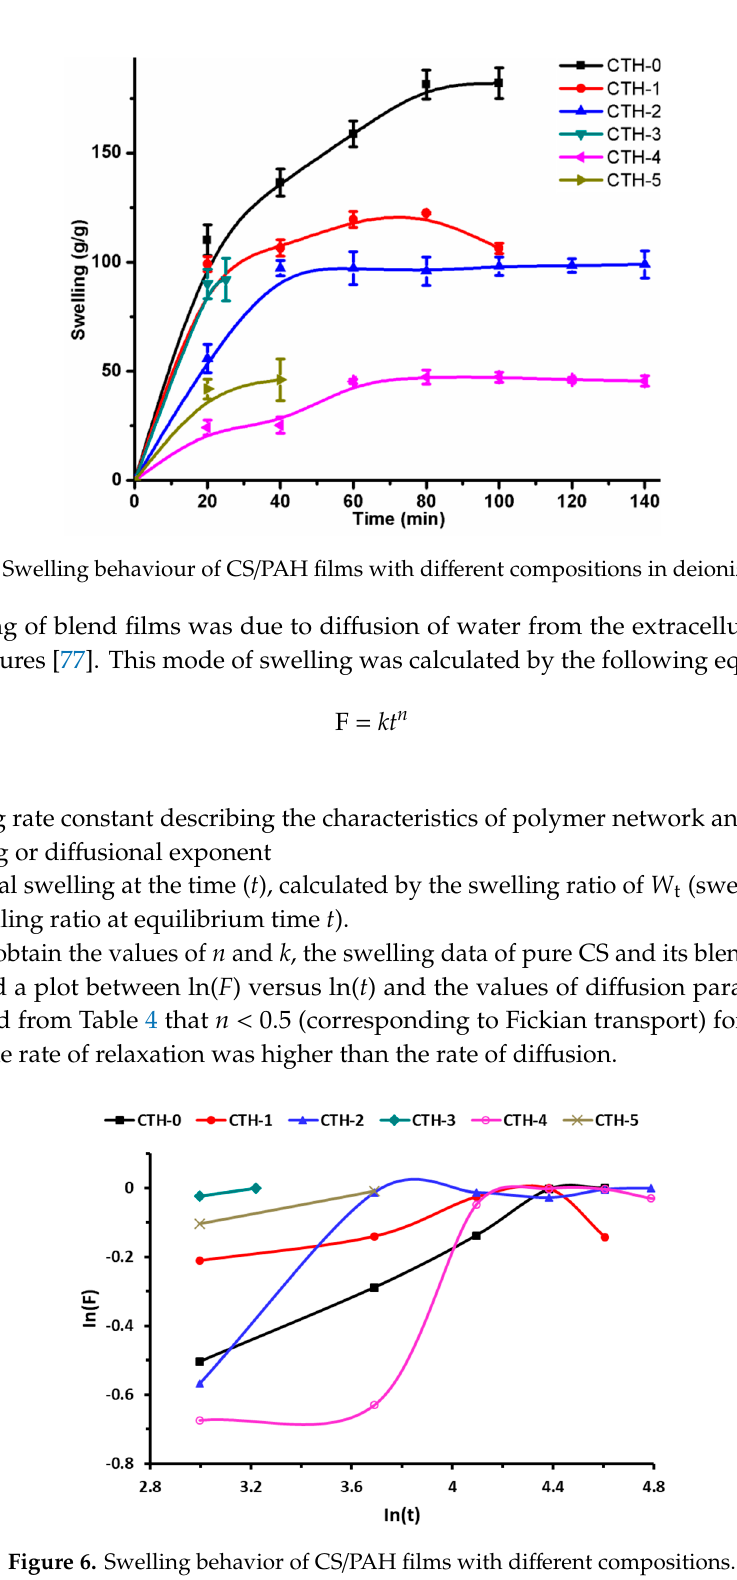
Figure 6. Swelling behavior of CS/PAH films with different compositions. Table 4. Diffusion parameters of different CS/PAH films.